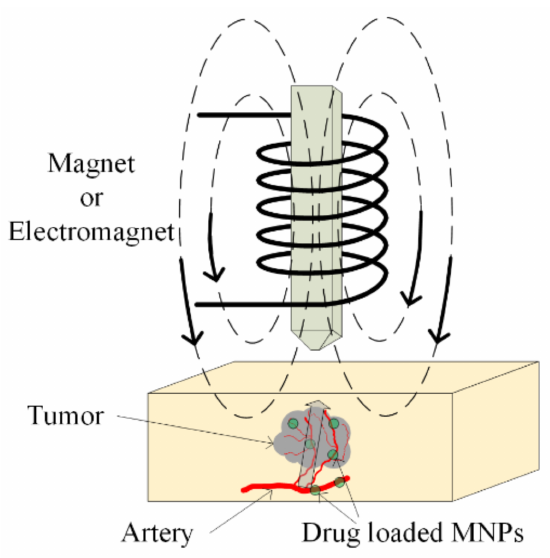
Figure 13. Magnetic drug targeting application. Drug-loaded MNPs are directly injected in the arterial blood of the tumor. A magnetic field is applied, and it causes MNPs’ enhancement in the tumoral